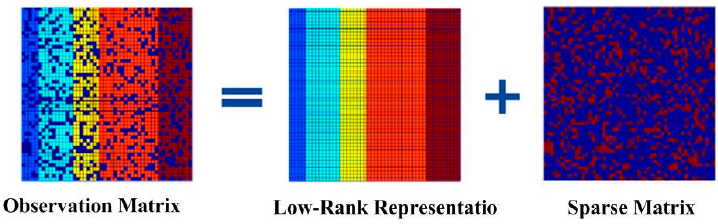
Figure 9. Sparse and low-rank matrix decomposition.